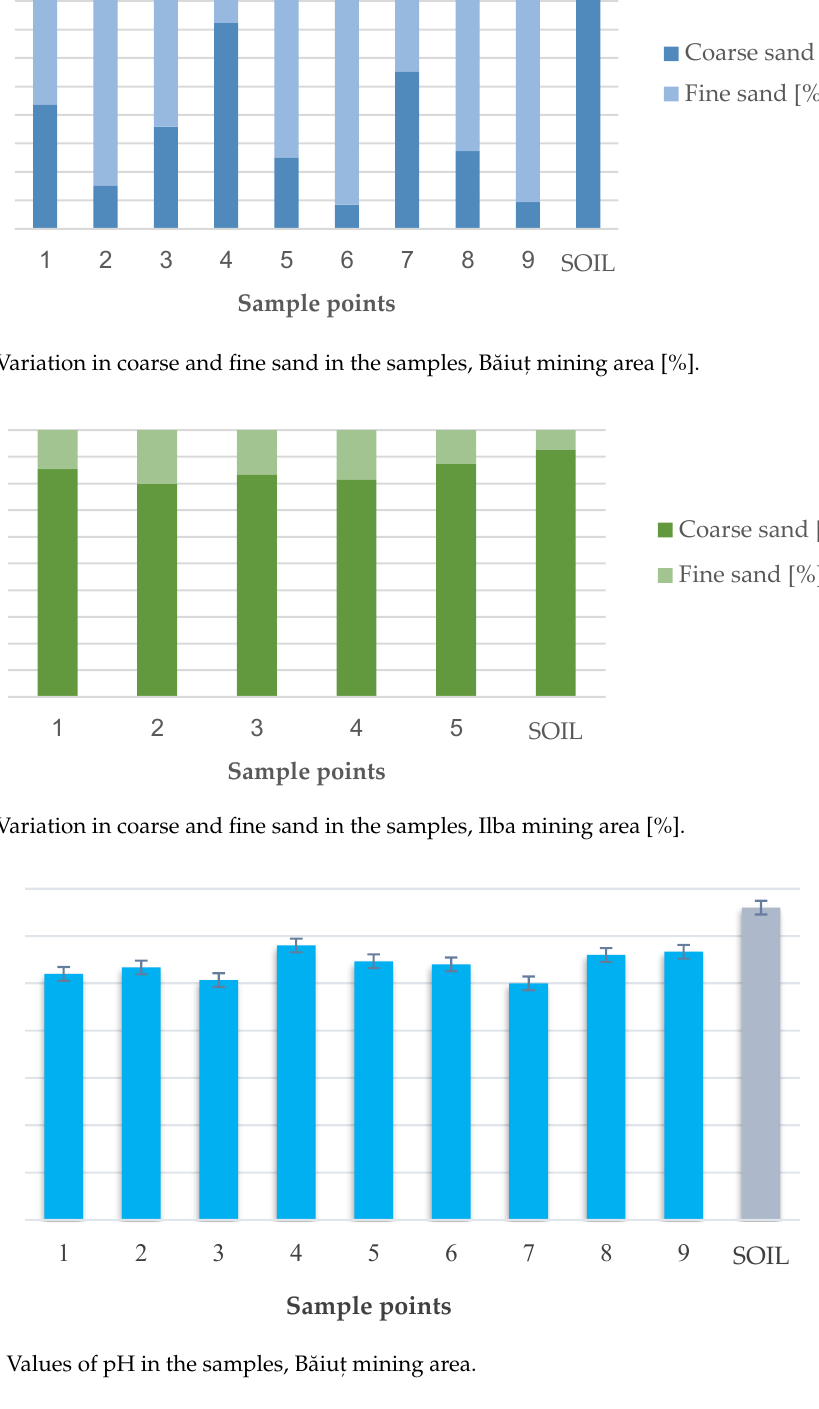
Figure 10. Values of pH in the samples, Băiuț mining area .